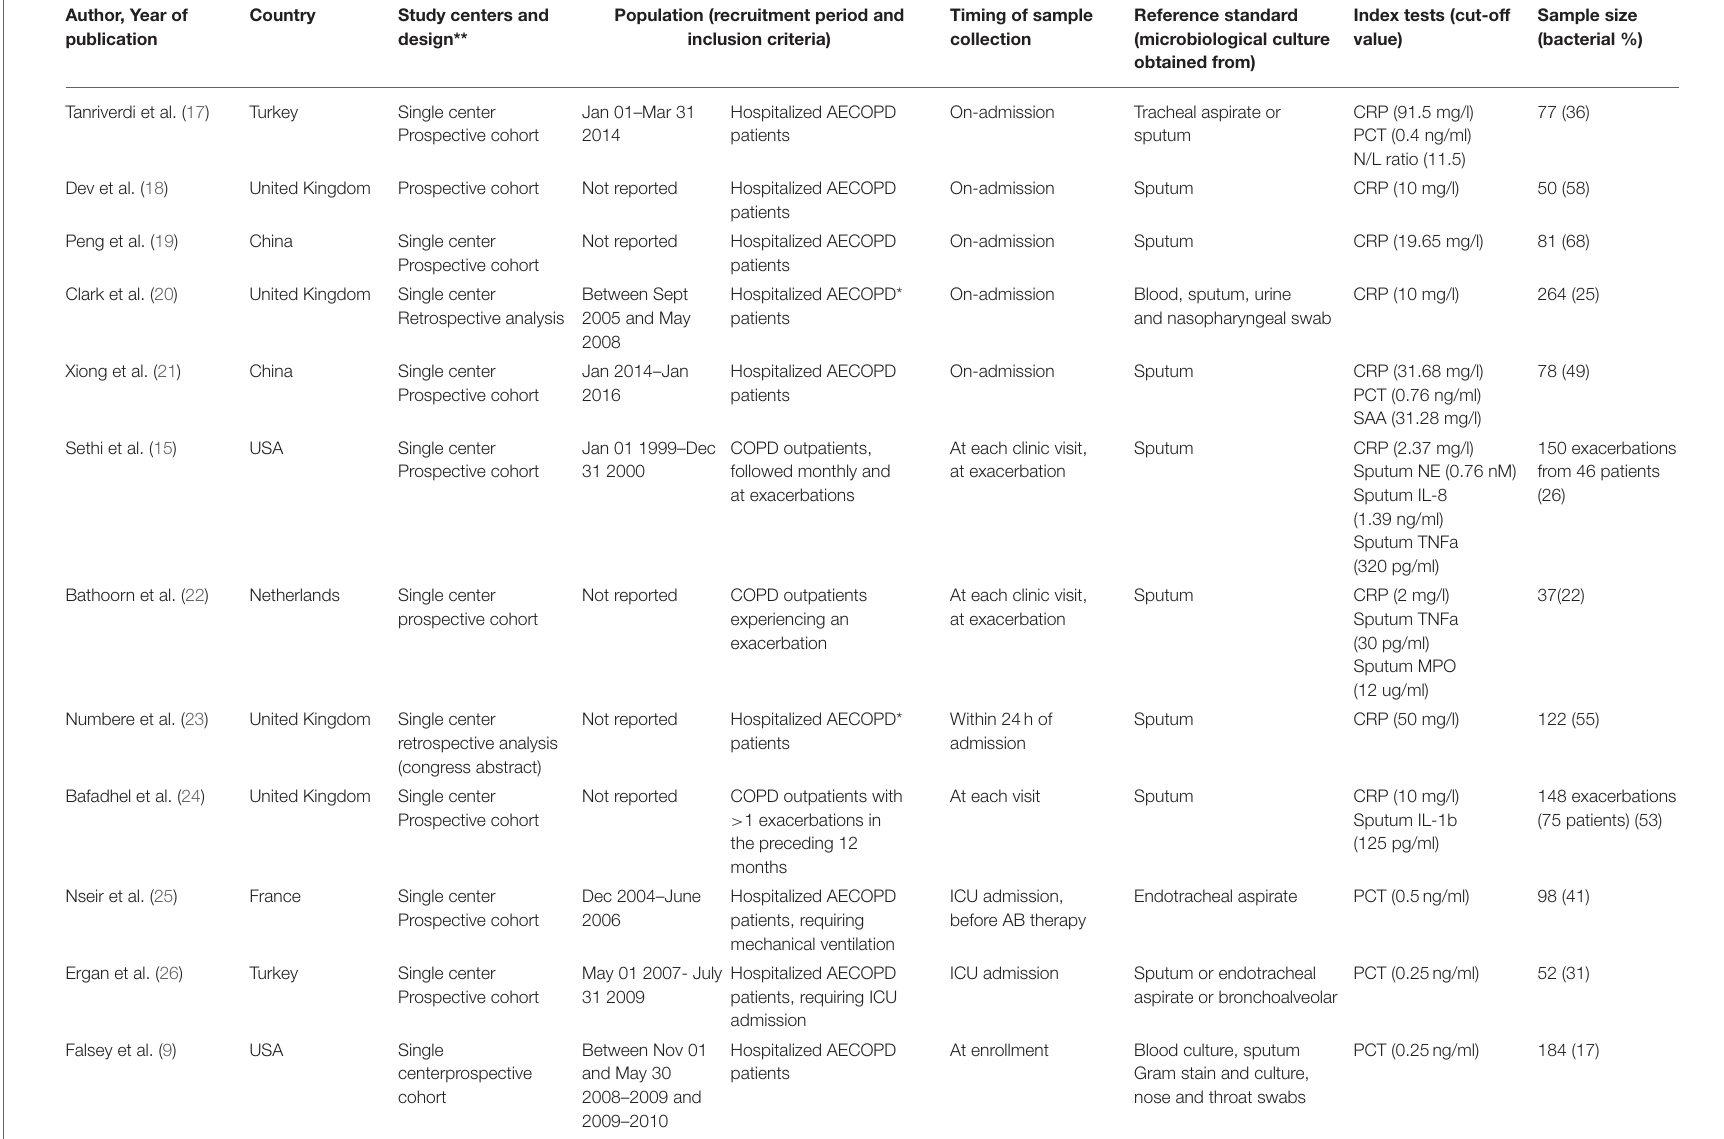
TABLE 1 | Characteristics of included